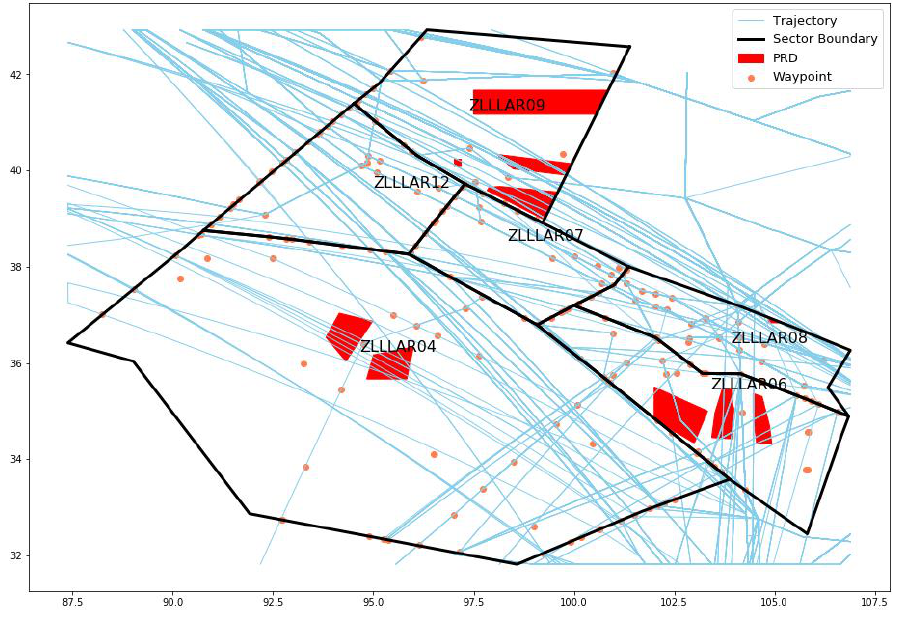
Figure 7. Lanzhou regional control airspace scenarios.